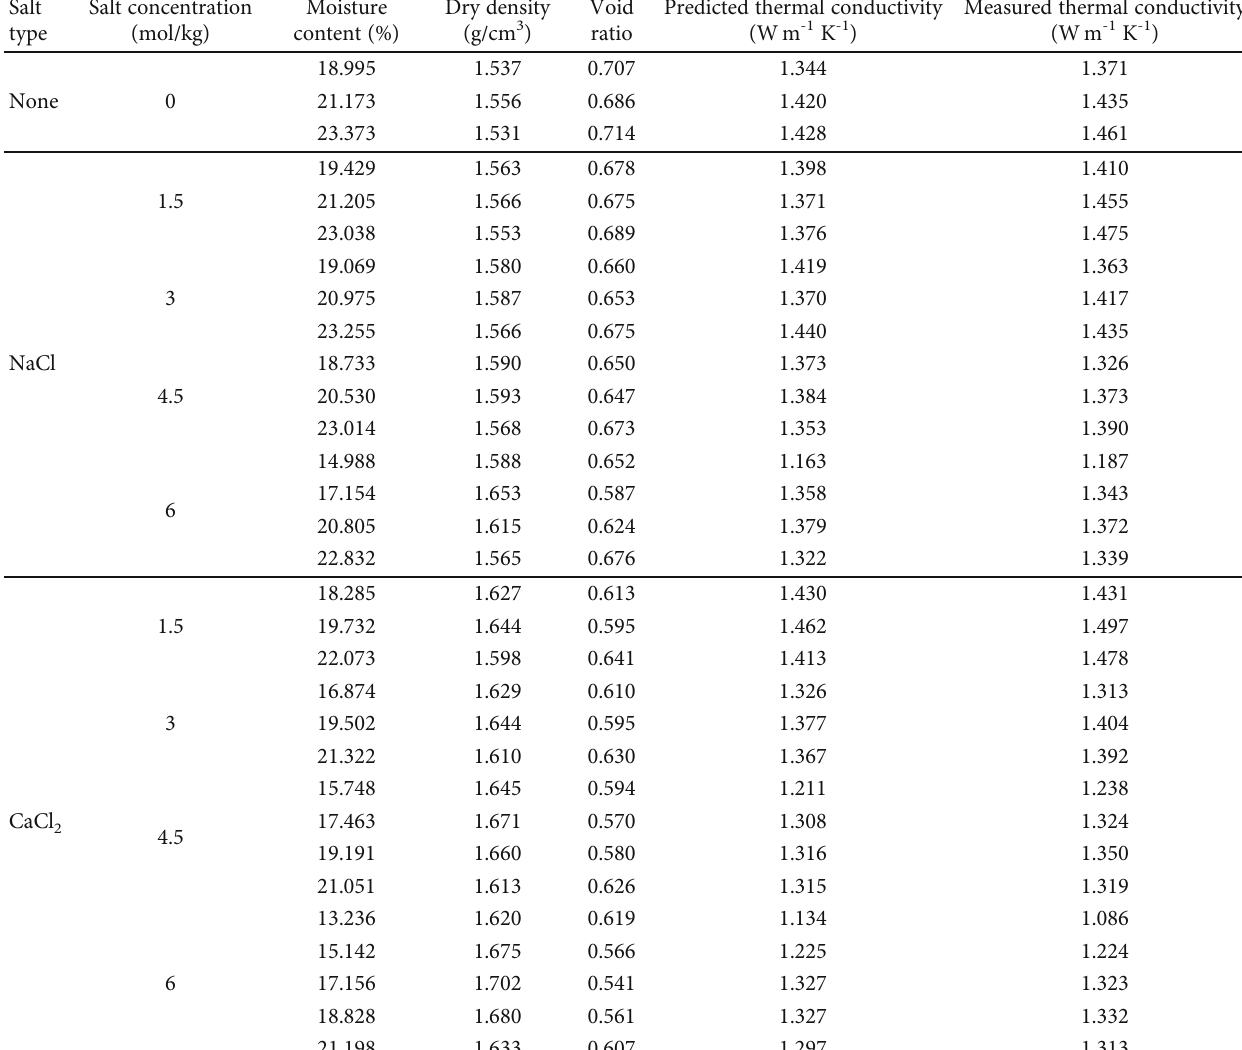
Table 3: The properties of reproduced